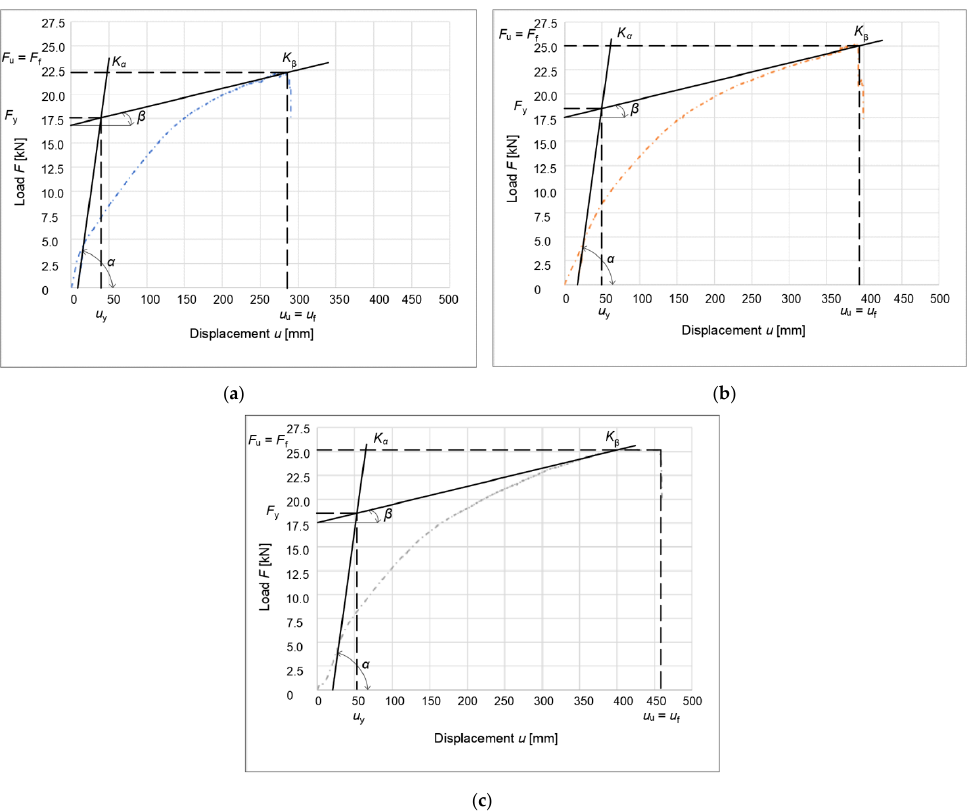
Figure 17. Graphical representation of the yield strength of a connection formed from bolts and dowels according to EN 12512 : ( a ) unreinforced specimen; ( b ) reinforced partitions; ( c ) reinforced rung and struts (stands). K α , stiffness of the connection at the yield point; K β , stiffness of the connec- tion at the ultimate point; α, slope of the curve at the yield point; β, slope of the curve at the ultimate point; u y , deformation at the yield point; u u , deformation at the ultimate point; u f , deformation at the failure point; F y , force at the yield point; F u , force at the ultimate point; and F f , force at the failure point.